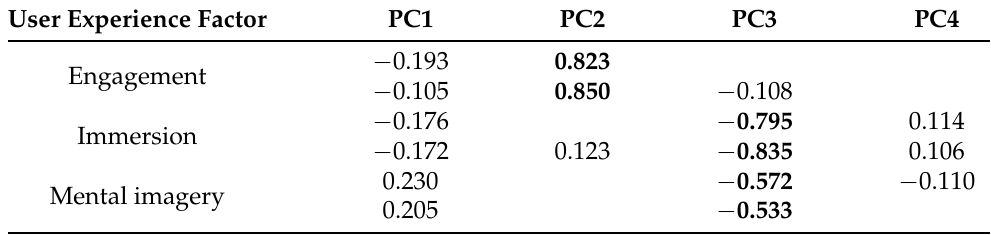
Table 4. Loadings obtained through varimax and promax rotations on the first three principal components for the user experience factors. Bold represents loadings that are considered